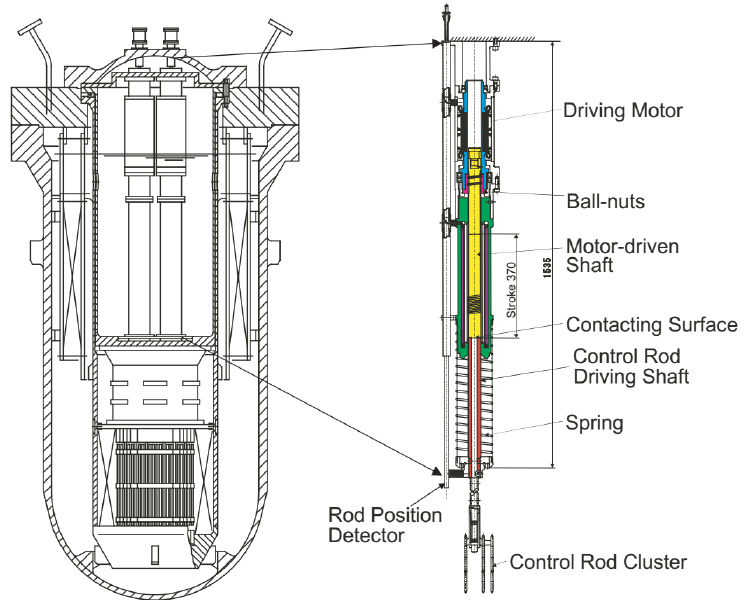
Figure 1. Structure of control rod mechanism.